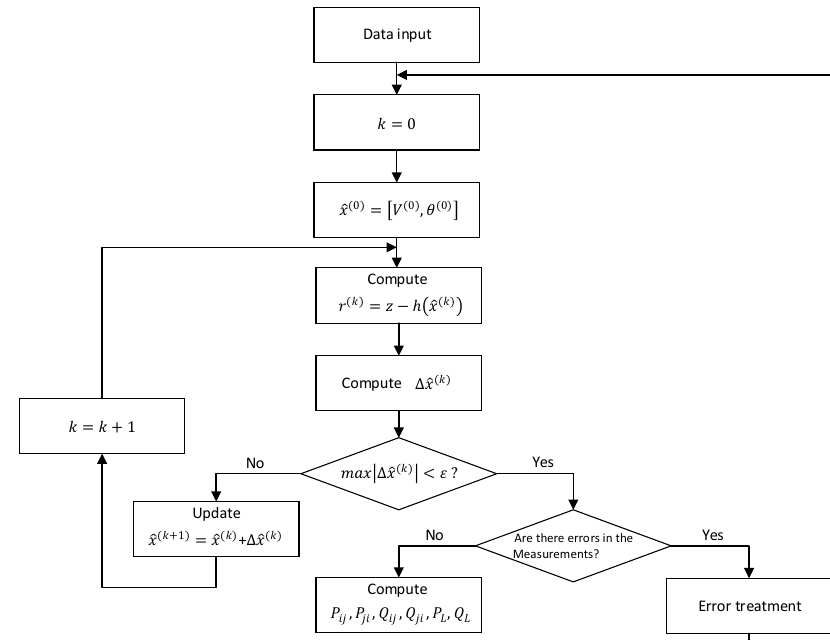
Figure 1. WLS state estimation